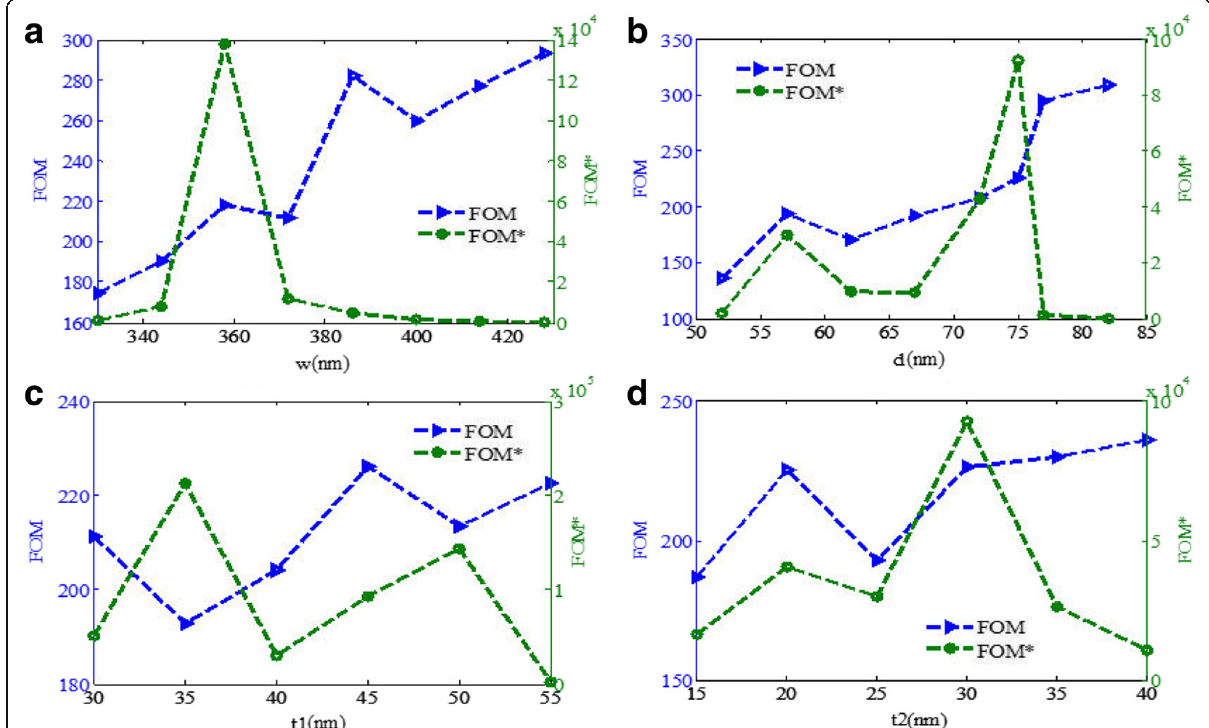
Fig. 11 a – d FOM and FOM* as functions of the gold nanoribbon width w , the triangular gold nanoribbon width d , the gold nanoribbons thickness t 1 , and the triangular gold height t 2 ,